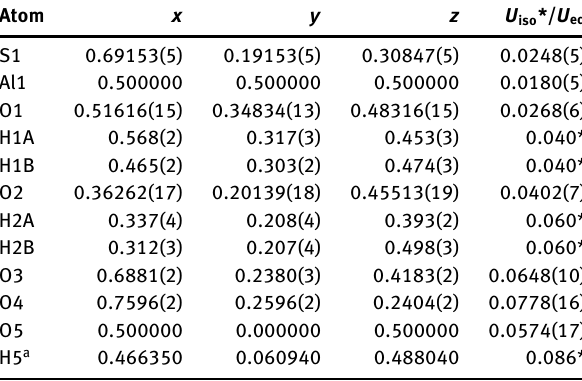
Table 2: Fractional atomic coordinates and isotropic or equivalent isotropic displacement parameters (Å 2